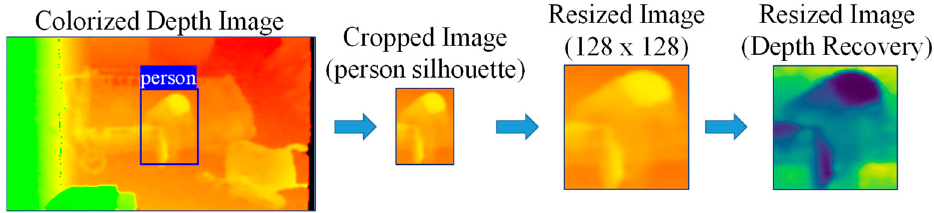
Figure 6. Person silhouette cropping, resizing, and depth recovery.